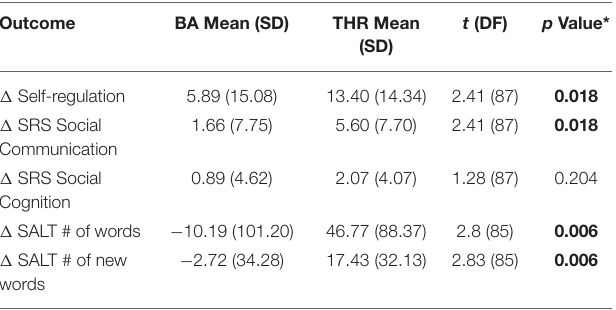
TABLE 2 | Efficacy analyses of the subset of completers included in mediation analyses.